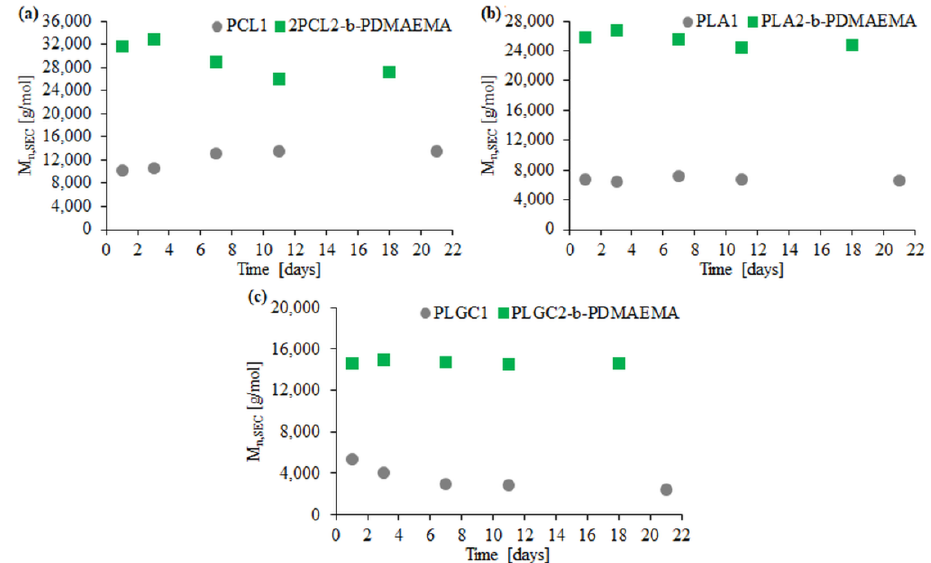
Figure 5. Graphs of M n loss dependence of the polyester block over time for 2PCL2- b- PDMAEMA ( a ), PLA2- b- PDMAEMA ( b ) and PLGC2- b- PDMAEMA ( c ) based on SEC.